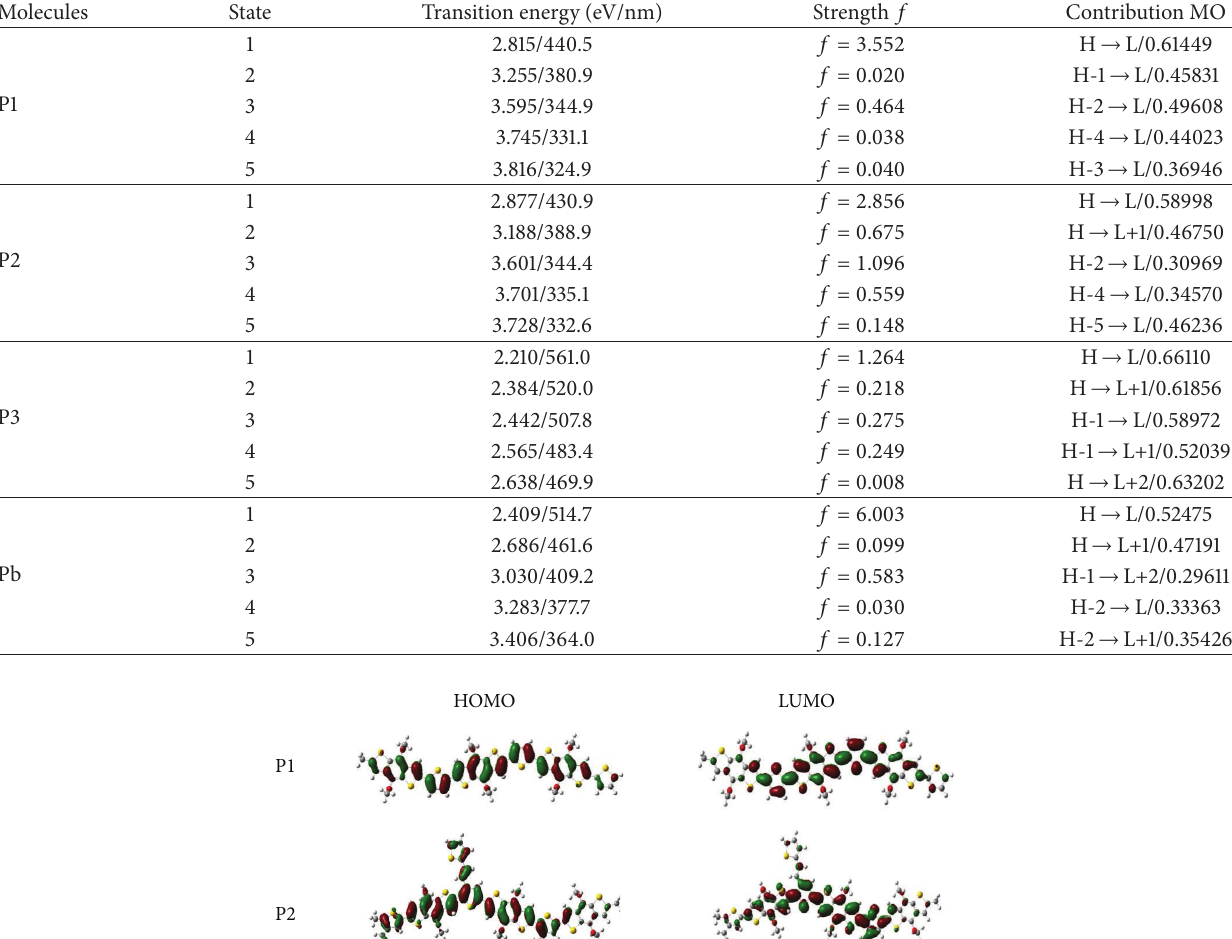
Table 4: Transition energy and oscillator strengths for four molecules ( 𝑛 = 3 ).